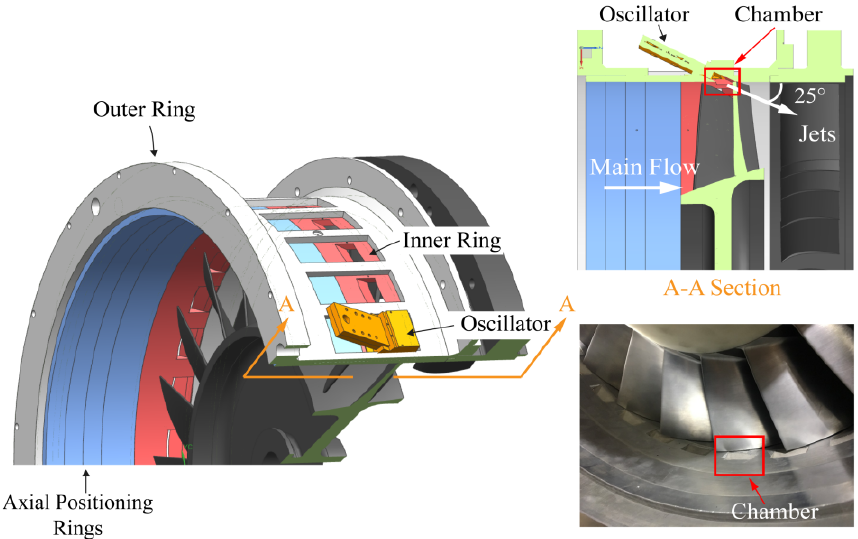
Figure 5. The test casing.